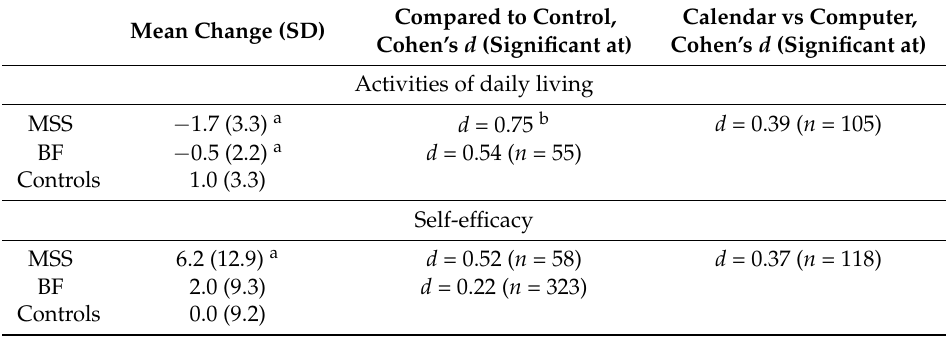
Table 2. Change in Memory Activities of Daily Living and Self-Efficacy at the End of Training. Compared to Control, Calendar vs Computer, Mean Change (SD) Cohen’s d (Significant at) Cohen’s d (Significant at) Activities of daily